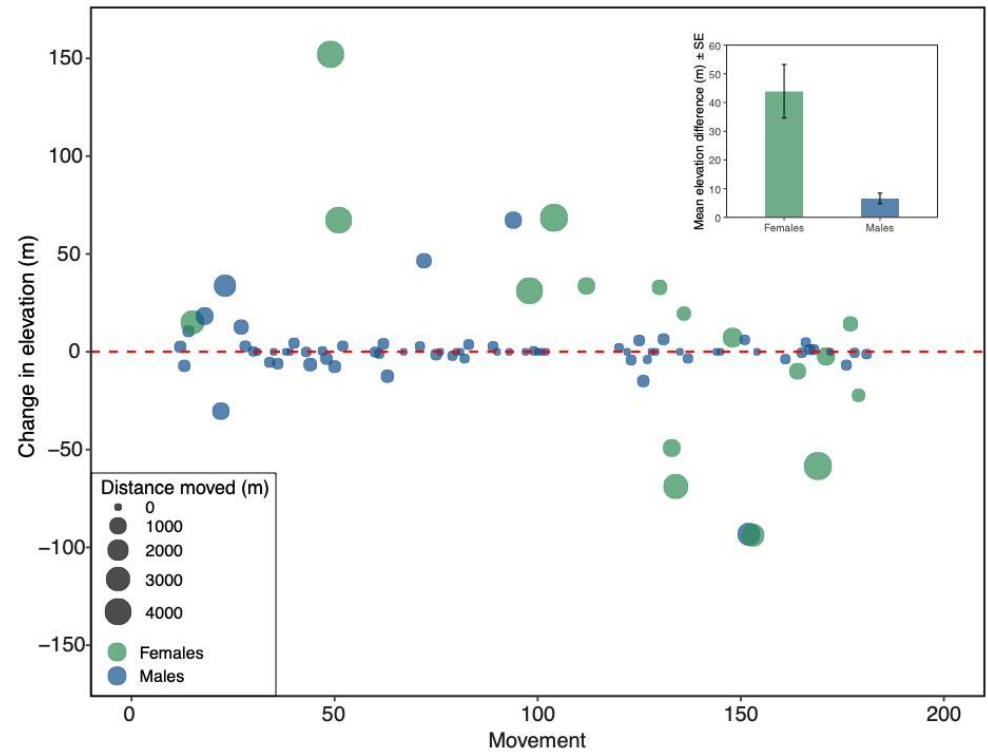
Figure 3. Sex differences in elevational changes between nesting locations from one year to the next for fledglings captured twice ( n = 87). Each point represents an individual bird movement. Green circles depict females, and blue circles depict males. The size of each point corresponds to the straight-line distance between nest boxes. Inset: Mean ( ± SE) elevation difference (absolute values) between males and females. Females changed elevation more than males (Mann–Whitney U test: W = 719, p < 0.001).